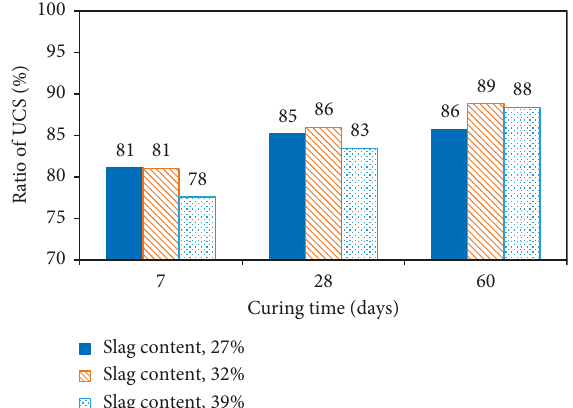
Figure 7: Ratio of unconfined compressive strength for CTB.